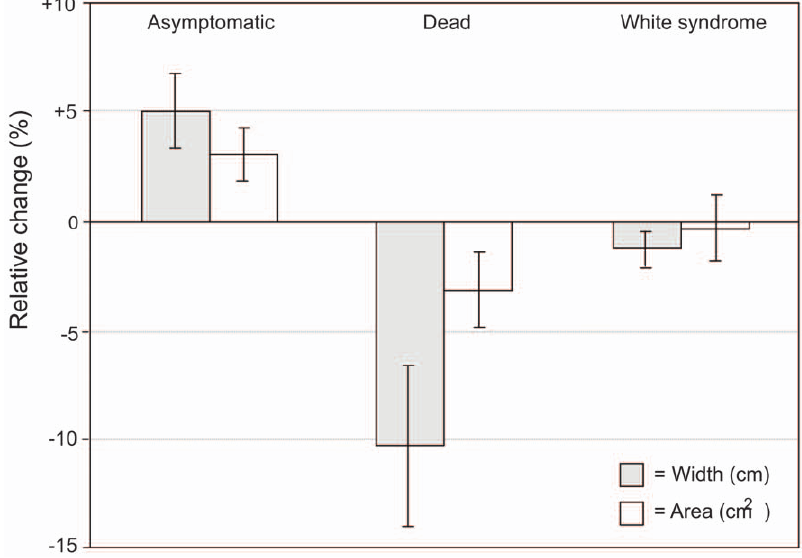
Figure 9. Relative change in growth in tabular Acropora spp. monitored during 2004.